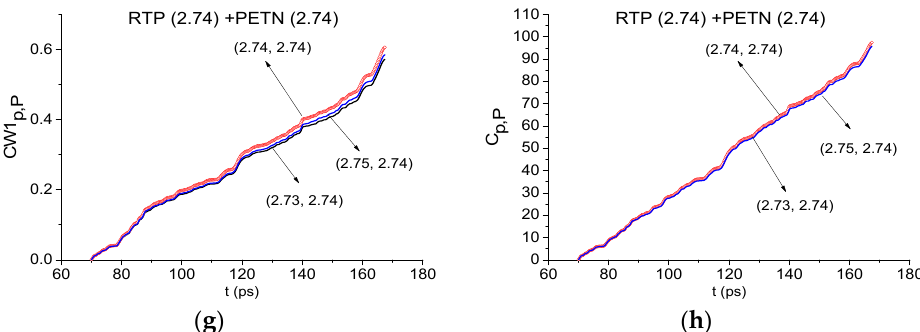
Figure 20. Time-dependent ICC CW 1 p , P (a,c,e,g) and C p , P ( b,d,f,h ) detecting frequencies ν = 3.0 THz ( a,b ), 3.71 THz ( c,d ), 2.88 THz ( e,f ) and 2.74 THz ( g,h ) in the RTH ( a–f ) and RTP ( g,h ) signals in the time interval t = [70, 170] ps.